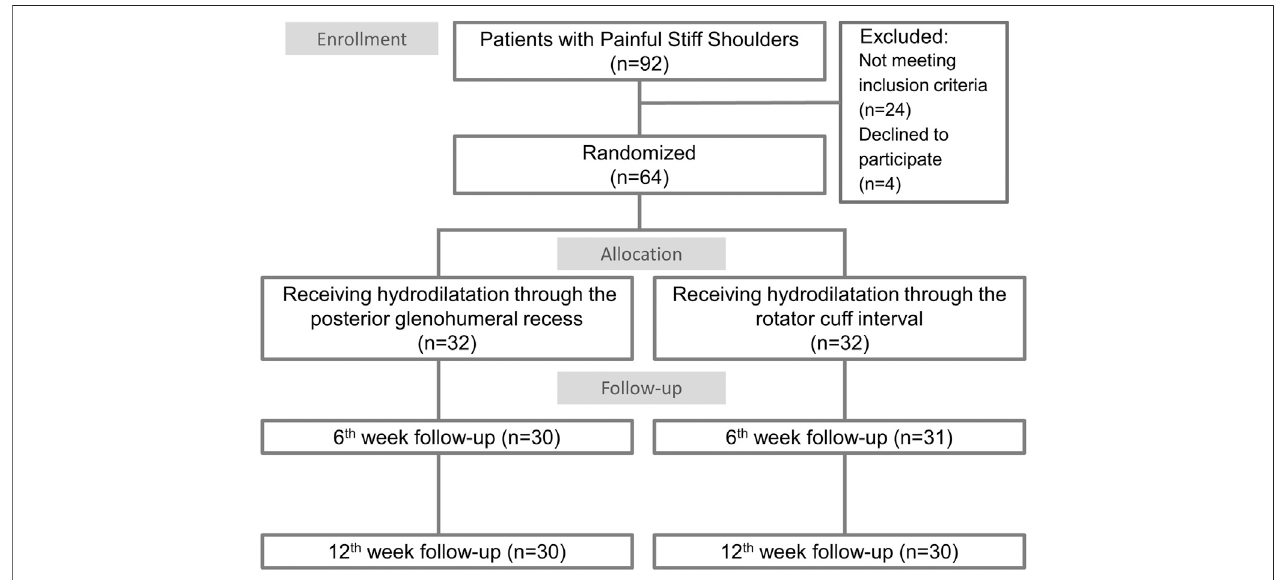
FIGURE 2 | Study fl ow diagram for the groups receiving ultrasound guided hydrodilatation through the posterior glenohumeral recess or through the rotator cuff interval.